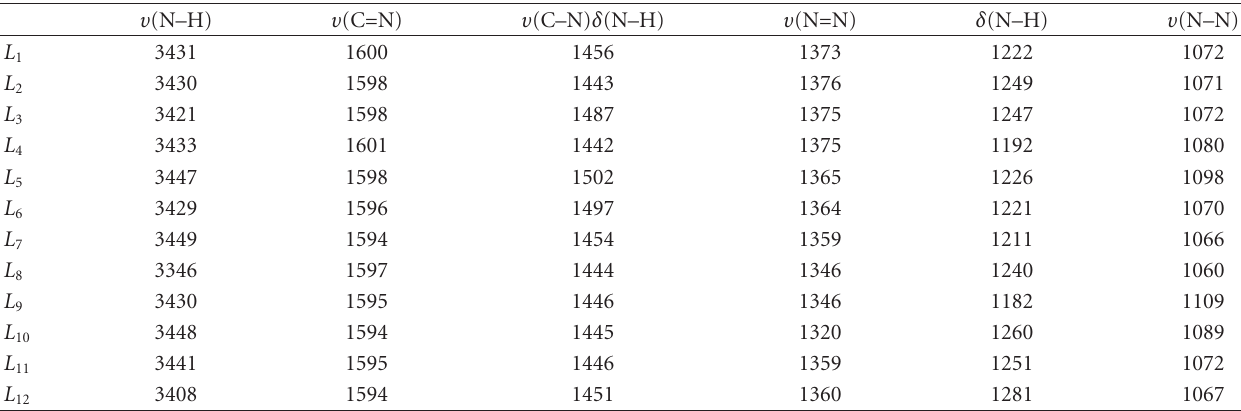
Table 2: Selected infrared data of the ligands (cm − 1